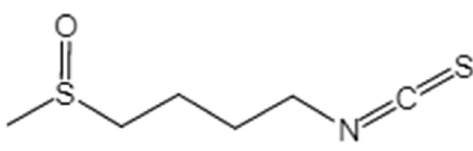
Figure 1. The chemical structure of sulforaphane Figure 1 . The chemical structure of sulforaphane (SFN).